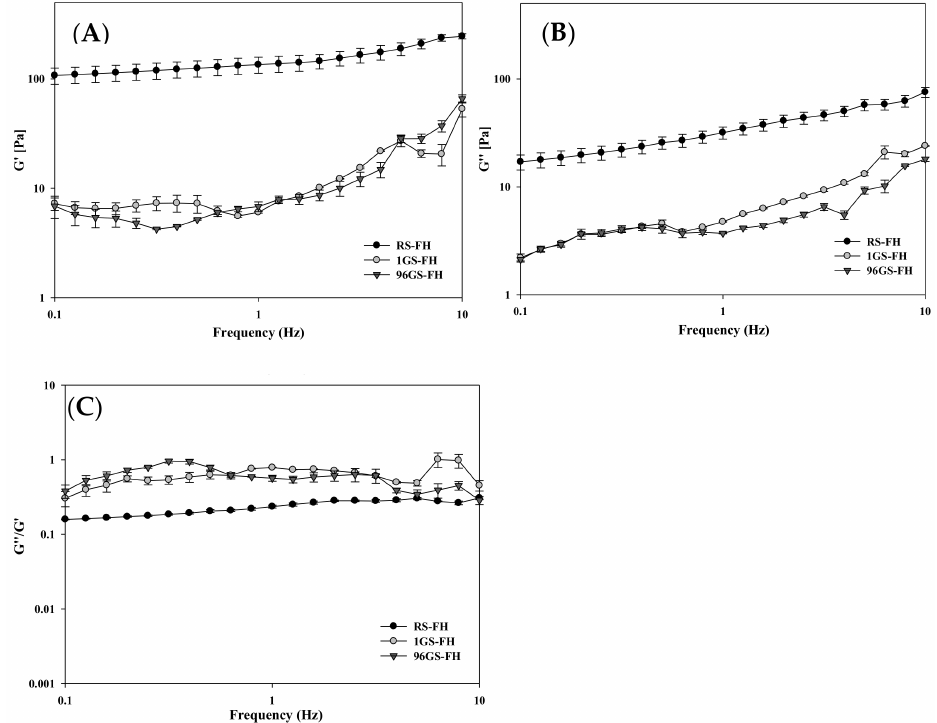
Figure 2. Rheological properties of filled hydrogel samples [native rice starch-based filled hydrogel (RS-FH), 4- α -glucanotransferase treated (for 1 h) rice starch-based filled hydrogel (1 GS-FH), and 4- α -glucanotransferase treated (for 96 h) rice starch-based filled hydrogel (96 GS-FH)] during a frequency sweep (0.1–10 Hz) at 25 ◦ C. The dynamic shear properties of the filled hydrogel were measured by ( A ) storage modulus (G (cid:48) ), ( B ) loss modulus (G”), and ( C ) loss tangent (tan δ = G”/G (cid:48) ). The error bars represent the mean and standard deviations of triplicate